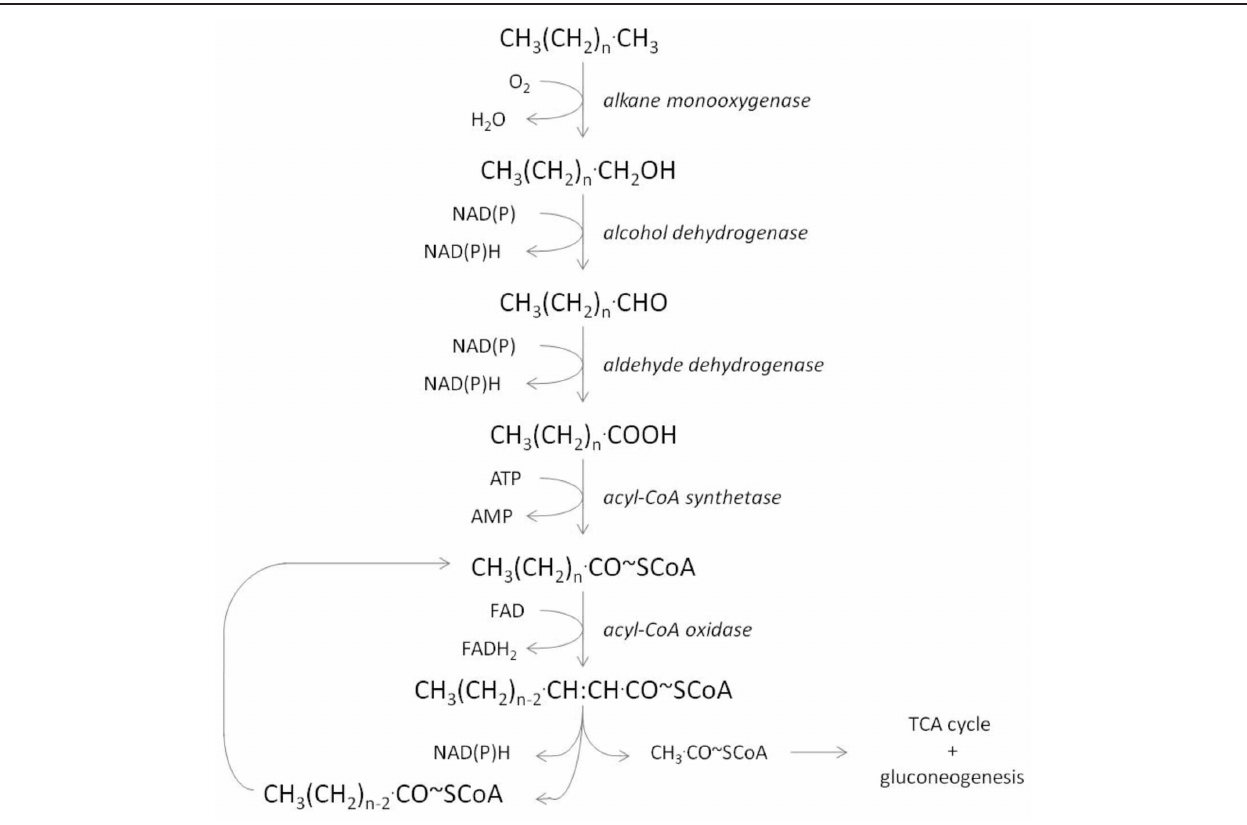
FIGURE 3 | Proposed main catabolic pathway for alkane